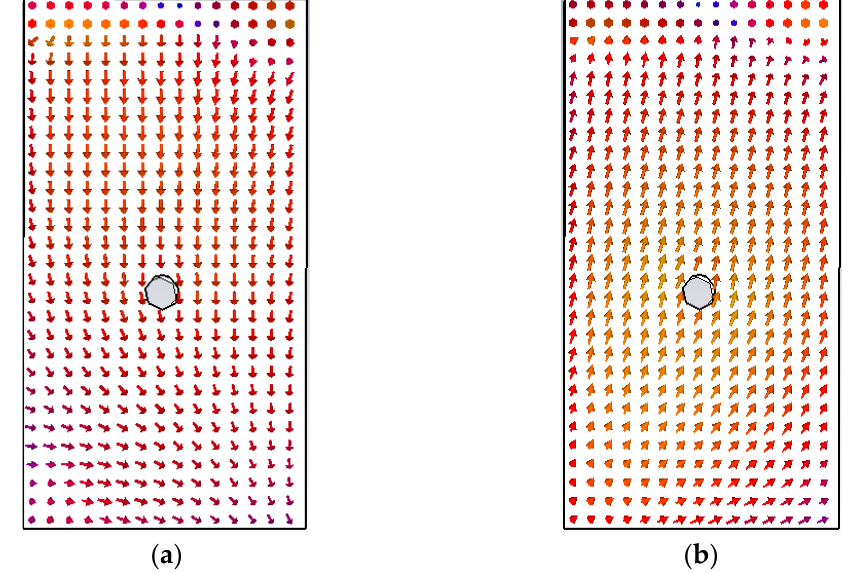
Figure 9. Electric field distribution on the top surface of the DR at ( a ) T = 0, and ( b ) T = t/4.